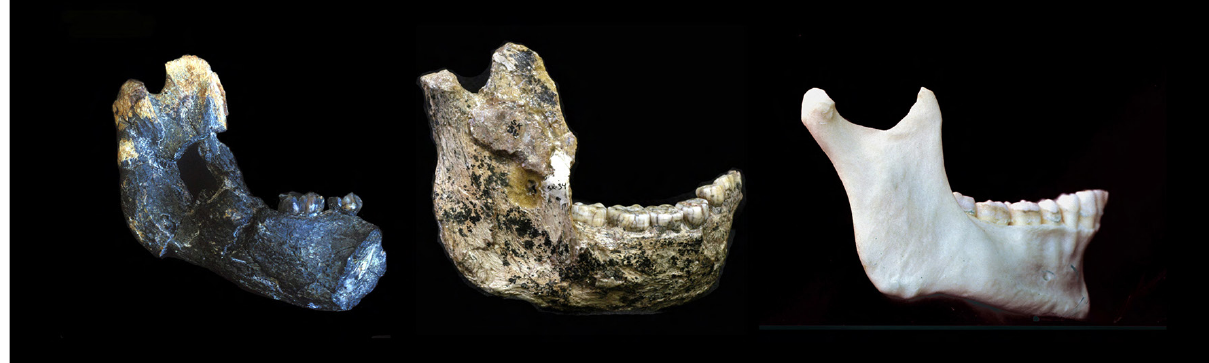
Figure 2: Comparison of ramal morphology in three specimens, left to right (not shown to scale): A.L. 33343 (infant), SK 34 (mature individual), and modern Homo sapiens (mature individual). Note that the two australopith rami are virtually identical in shape despite their difference in individual age, and their shape differs from that of the generalised (i.e. shared) configuration, which is seen in H. sapiens .